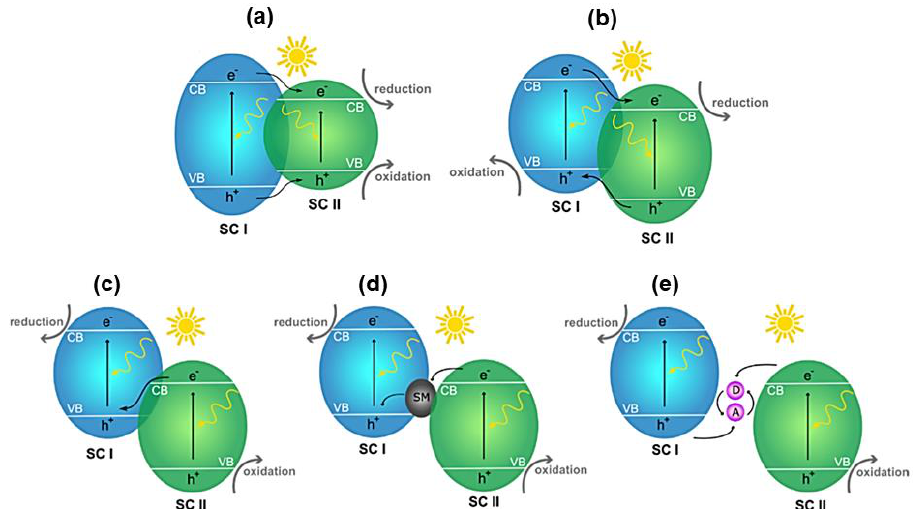
Figure 3. Heterojunction types by band position: ( a ) type I (straddling gap), ( b ) type II (staggered gap), ( c ) direct Z-scheme or mediator-free, ( d ) solid mediator, and ( e ) redox pair mediator. Reproduced with permission from [54]. Copyright 2020 Elsevier.